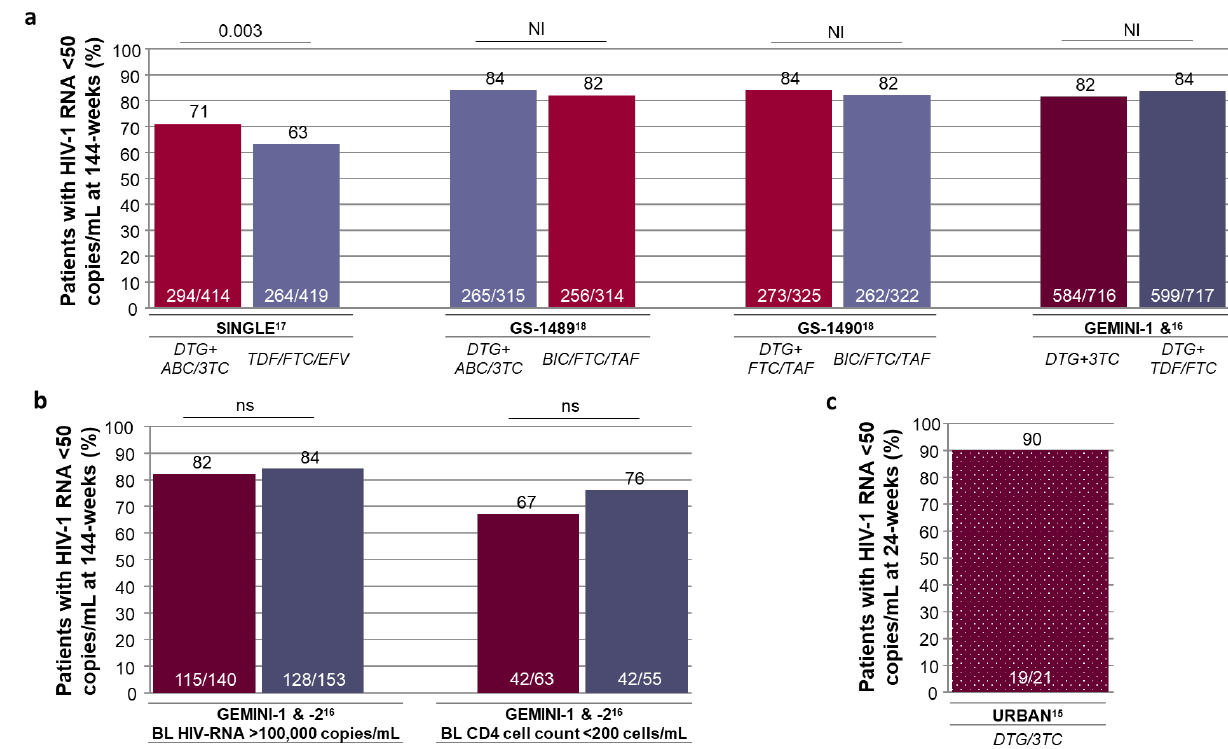
Figure 1. Dolutegravir plus lamivudine two- and three-drug regimens in treatment-naïve patients. ( a ) Efficacy in random- ized clinical trials by FDA snapshot analysis at week-144. Histograms represent individual studies—not a head-to-head comparison. ( b ) Efficacy of dolutegravir plus lamivudine in GEMINI-1 and GEMINI-2 randomized clinical trials by FDA snapshot analysis at week-144, in patients with baseline viral load >100,000 copies/mL, and in patients with baseline CD4 cell count <200 copies/mL. ( c ) Efficacy of dolutegravir plus lamivudine in URBAN real-life study, week-24 result in the effectiveness set (excluding missing data). 3TC = lamivudine; ABC = abacavir; BIC = bictegravir; BL = baseline; DTG = dolutegravir; EFV = efavirenz; FTC = emtricitabine; NI = noninferior treatment difference; ns = not statistically significant difference; TAF = tenofovir alafenamide; TDF = tenofovir disoproxil fumarate.